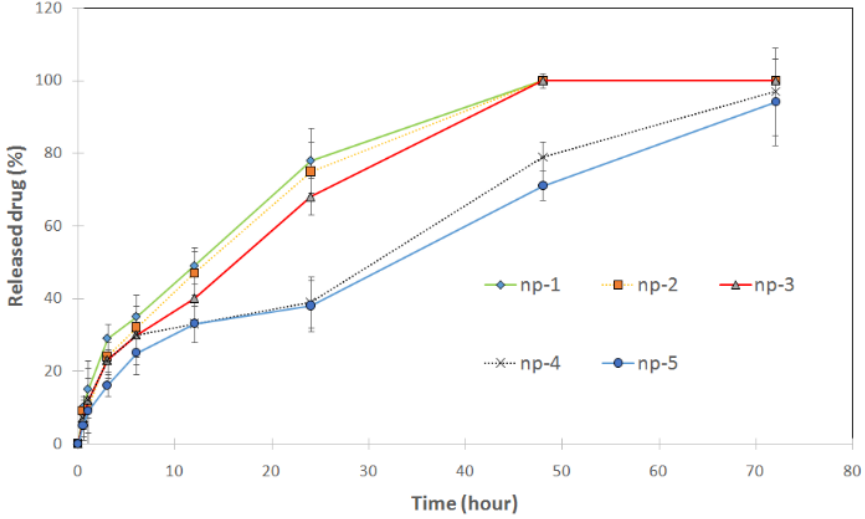
Fig. 3. Cumulative percentage of MTX release from PLGA nanoparticles in pH